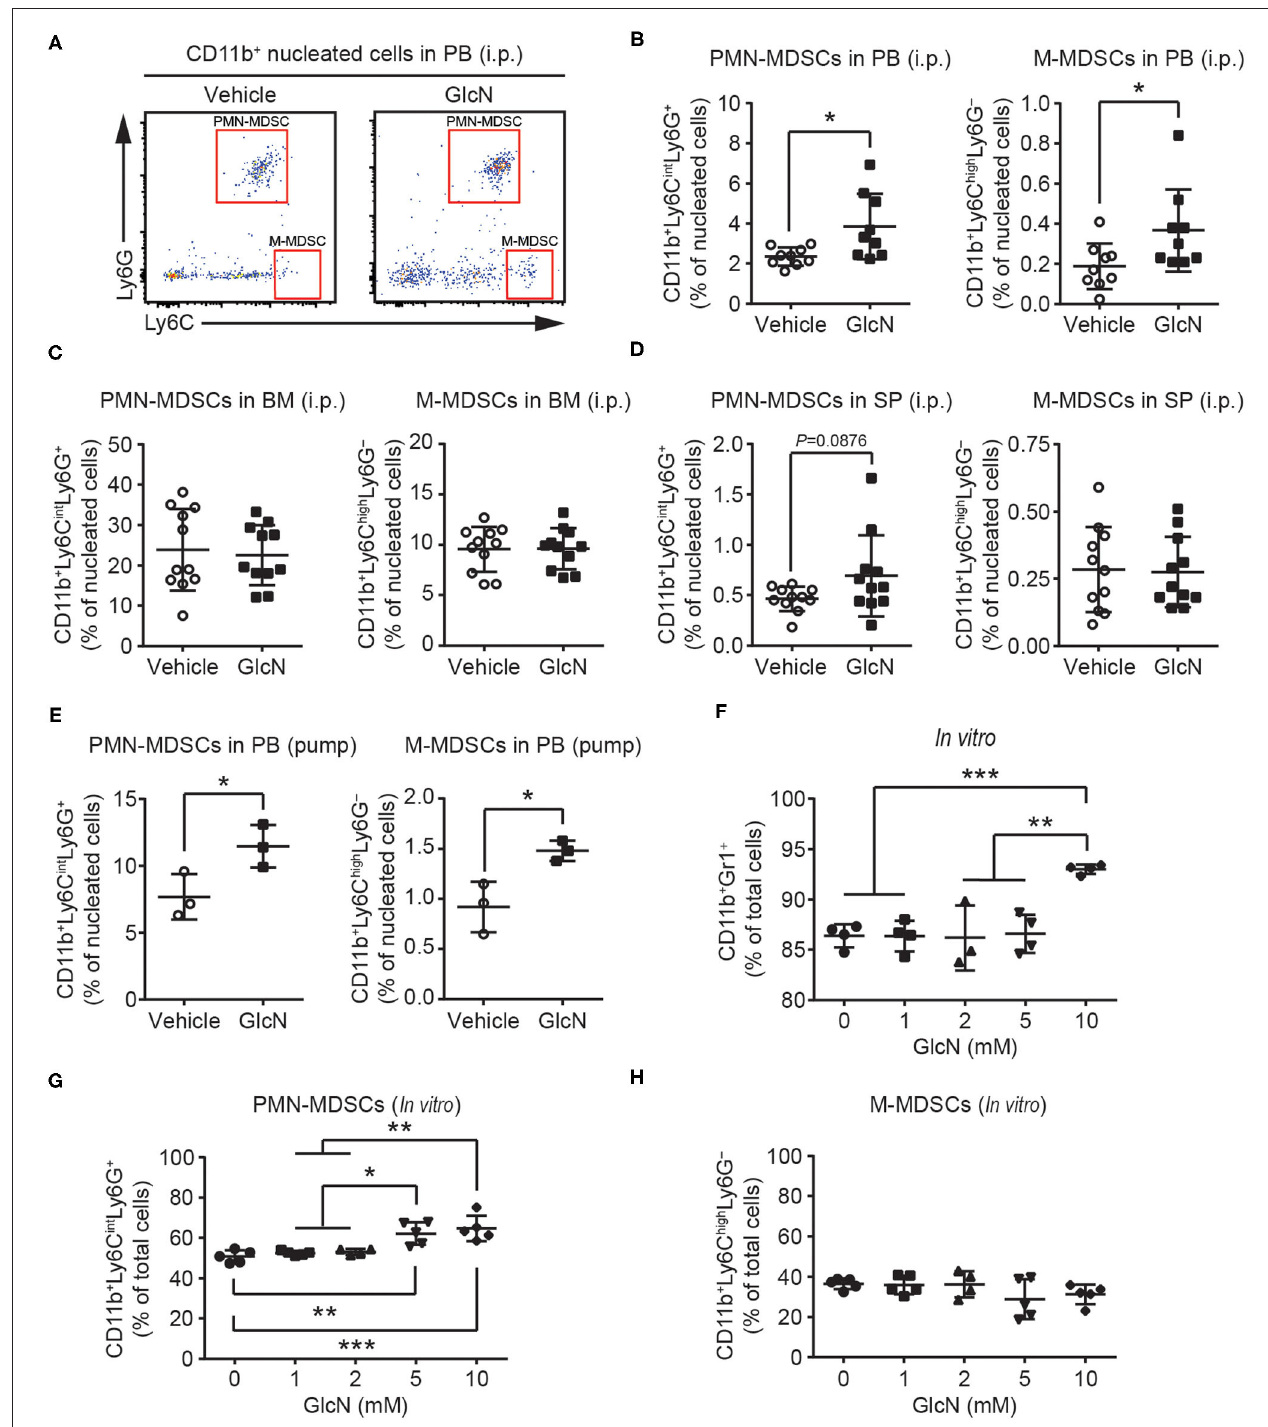
FIGURE 2 | GlcN supplementation expands the compartment of MDSCs. (A) Schematic of PMN-MDSC and M-MDSC flow cytometry gating. PMN-MDSC and M-MDSC levels in (B) peripheral blood (PB), (C) bone marrow (BM), (D) spleen (SP) following i.p. injection. (E) PMN-MDSC and M-MDSC levels in the PB following pump release. Wild-type BM cells were stimulated with IL-6, GM-CSF, G-CSF, and transforming growth factor- β (TGF- β ) to induce MDSC expansion in vitro . (F) Expanded CD11b + Gr1 + MDSC frequency. (G) Expanded PMN-MDSC frequency. (H) Expanded M-MDSC frequency. The quantified results are presented as the mean ± standard deviation. * P < 0.05; ** P < 0.01; *** P < 0.001.